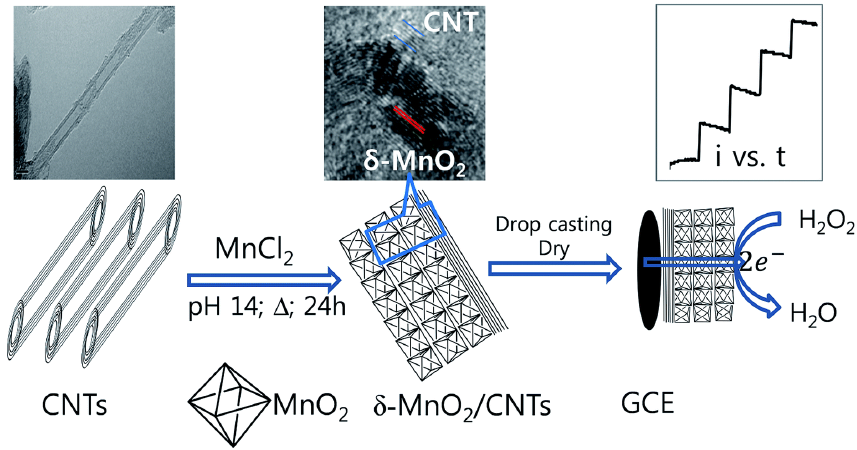
Figure 7. Scheme of the synthesis and application of a δ -MnO 2 nanocomposite with carbon nanotubes ( δ -MnO 2 /CNTs) as an enzyme-free sensor for the detection of hydrogen peroxide (H2O2) through an electroreduction reaction. ( Left ) carbon nanotubes; ( Middle ) synthesis of the δ -MnO 2 /CNTs nanocomposite by a simple one-step hydrothermal process in an alkaline solution without using surfactants or templates; ( Right ) investigation of the electrochemical properties of δ -MnO 2 /CNTs in a glassy carbon electrode by cyclic voltammetry and amperometry. With permission from